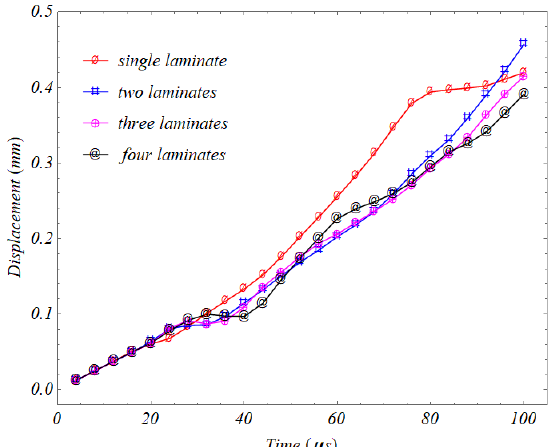
Fig. 25. Displacement against time for various number of cellphone casing laminates at 500mm drop